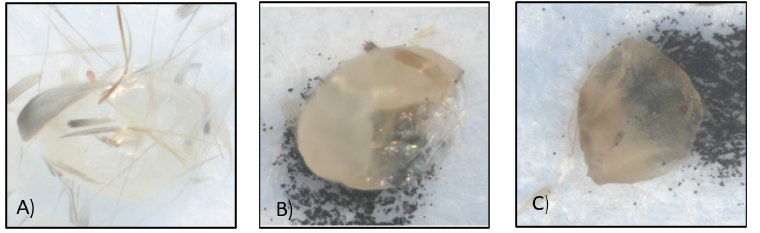
Figure 1. ( A ) Healthy egg. ( B ) Partially consumed egg. ( C ) Totally consumed